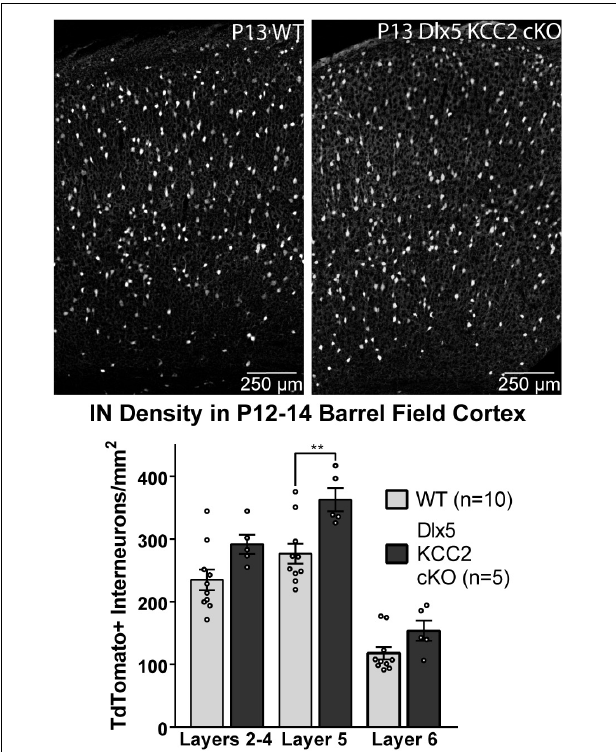
FIGURE 5 | Increase in Layer 5 INs in P12–14 Dlx5 KCC2 cKO Cortex. Bar graph shows densities of INs, labeled by cre reporter, by different layers of barrel field cortex in P12–14 WT, heterozygote, and Dlx5 KCC2 cKO. Images show examples of IN reporter expression in WT and Dlx5 KCC2 cKO